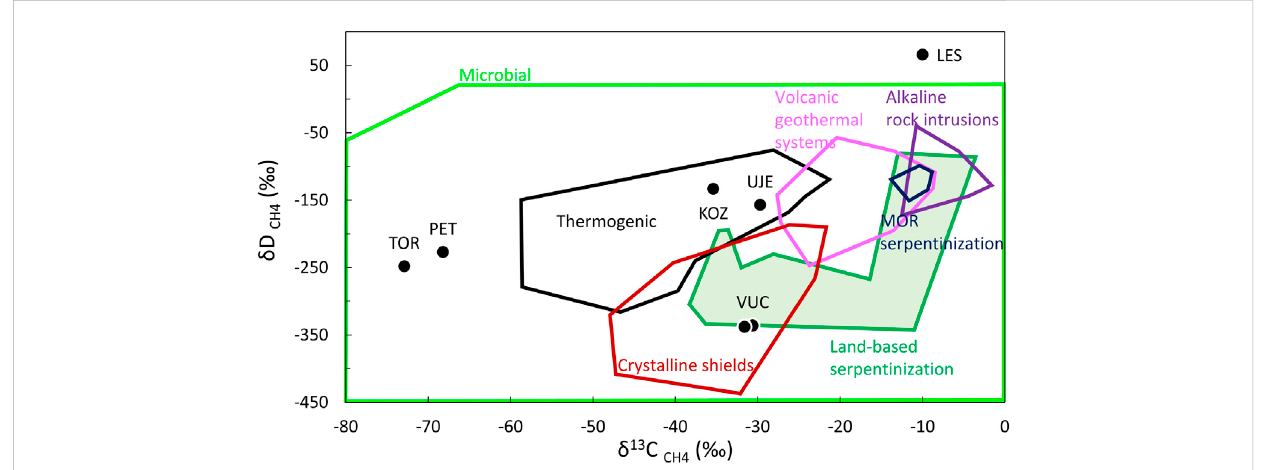
FIGURE 8 δ DofCH δ 13 CofCH 4 against 4 .ThedifferentzonesonthediagramarefromEtiope(2017)apartfromtherangede that was extended based on the study by Xia and Gao